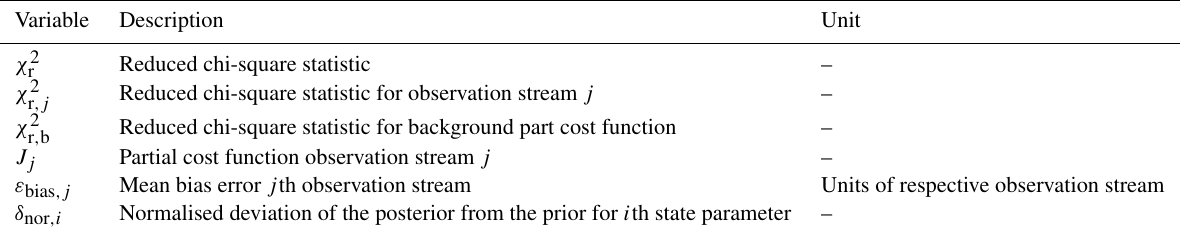
Table B2. Output variables defined in Sect.